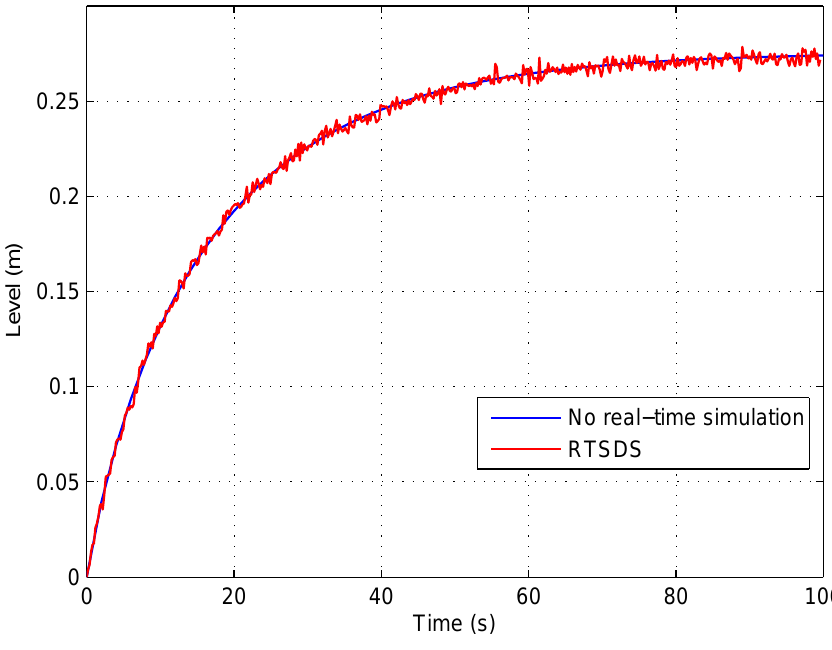
Figure 14. Results obtained for the RTSDS platform applied to the dynamic system characterized by Equation (5), with A = 15 . 518 cm 2 and q